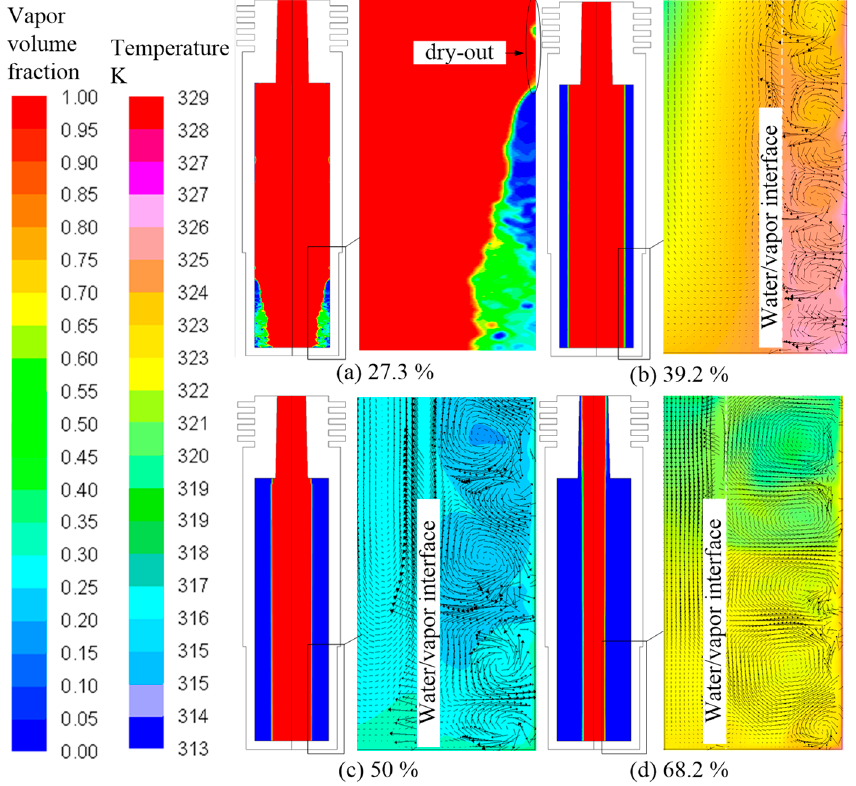
Figure 6. Heat transfer mechanism under different filling ratio.